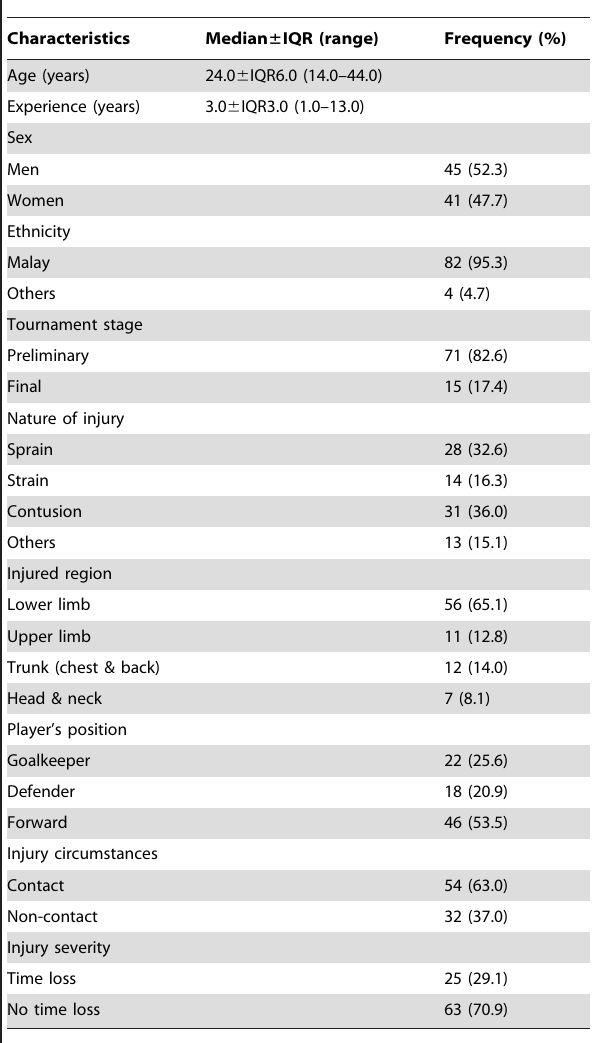
Table 1. Socio-demographic characteristics of injured players during the 2010 FELDA/FAM National Futsal League in